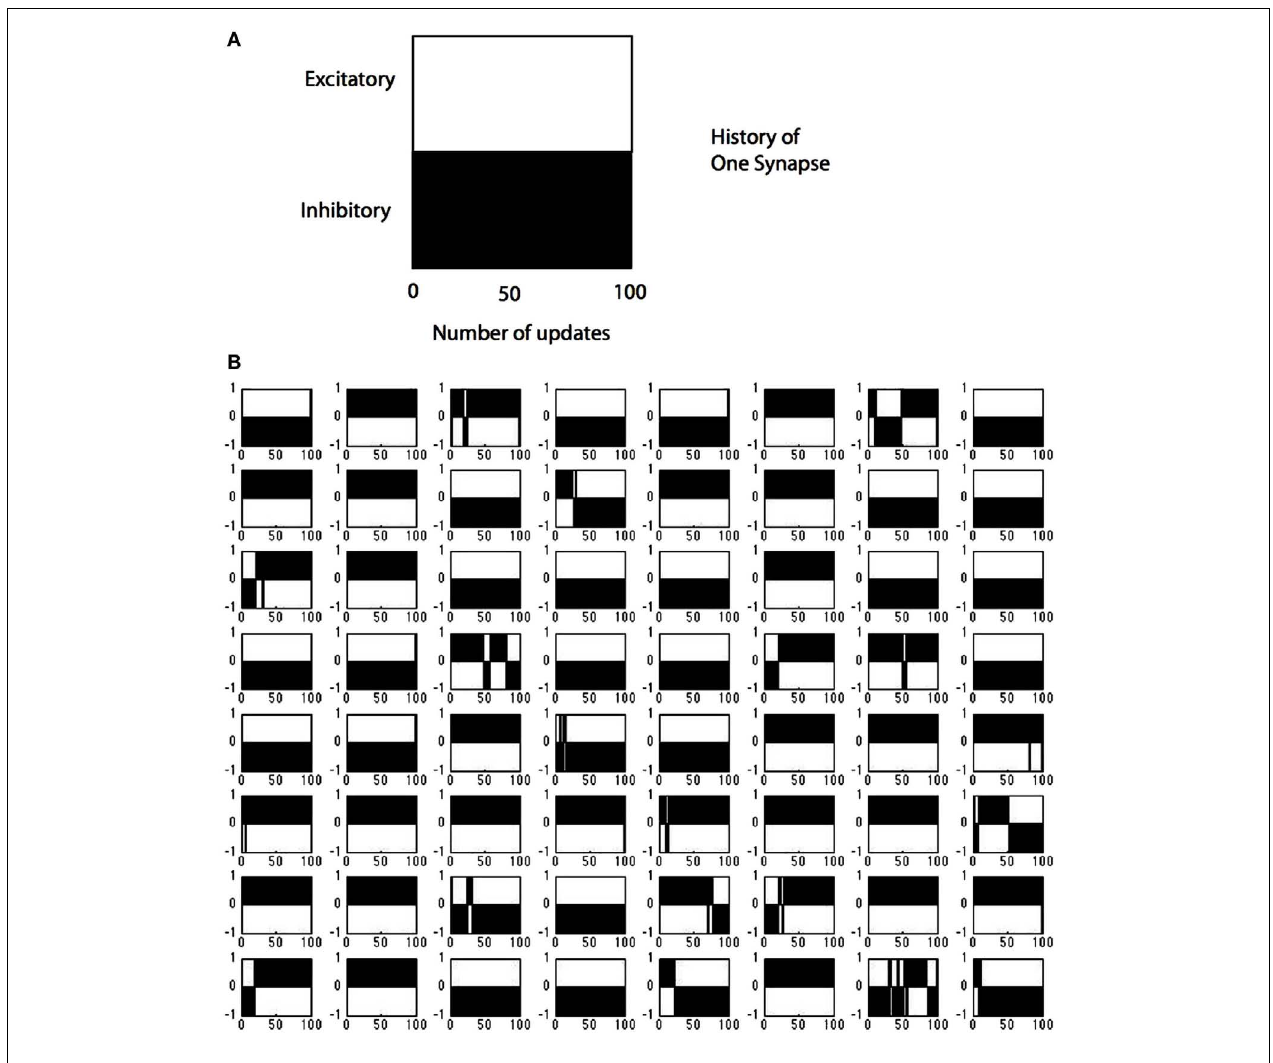
image stimulus.The figure represents two possible synapses at each location. Most locations can be represented by a single synapse that does not change sign, but at 19 positions the synapses need to change sign during the computation, some several times such as synapse position